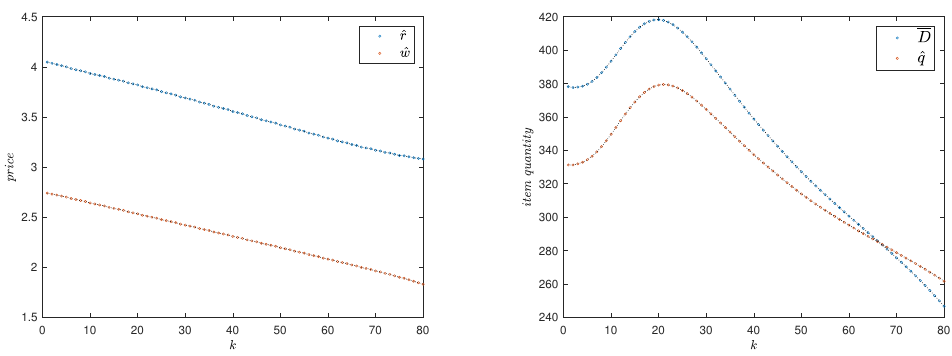
Figure 5. Market with positive network effect at equilibrium